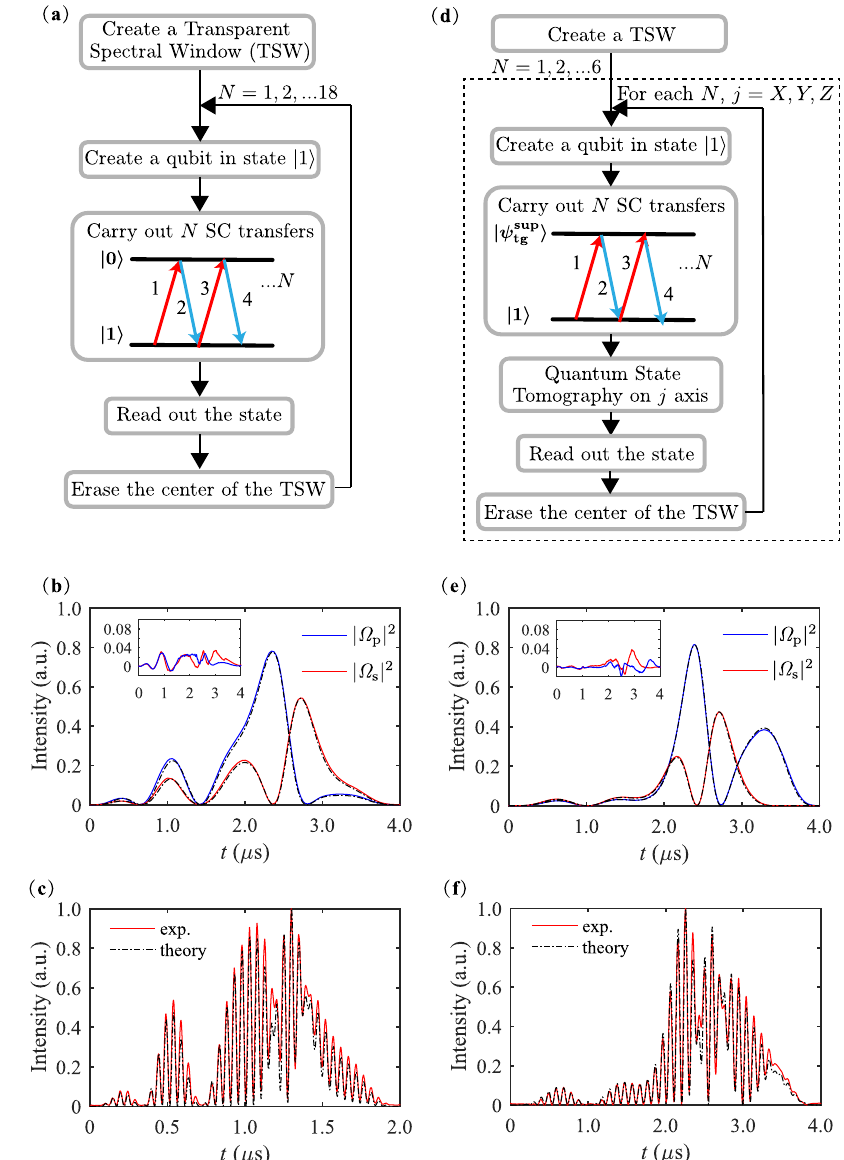
Fig. 2 Pulses sequences and pulse envelopes. The left panel shows the fi gures for the transfer between |1 〉 and |0 〉 , and the right panel for (cid:1) (cid:3) (cid:1) state. a , d Schematics of the pulse sequence used in experiments, where SC denotes shortcut. the transfer between |1 〉 and ψ sup tg b , e Intensity envelopes of the individual pulses in experiments (solid curves) and in theory (dash-dotted black curves). The blue curve shows | Ω p | 2 and the red | Ω s | 2 . The difference between the experimentally implemented pulses and the theoretical pulse shapes are shown by the insets. c , f Beating of the two fi elds in experiments (red curve) and in theory (dash-dotted black